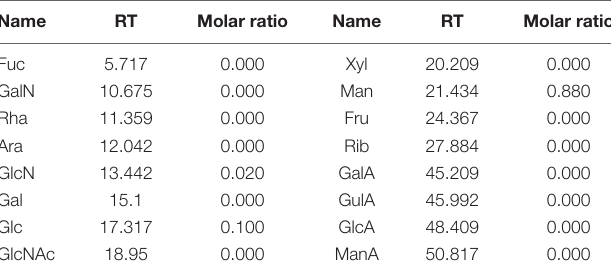
TABLE 1 | Monosaccharide compositions of S-EPS 2-1.